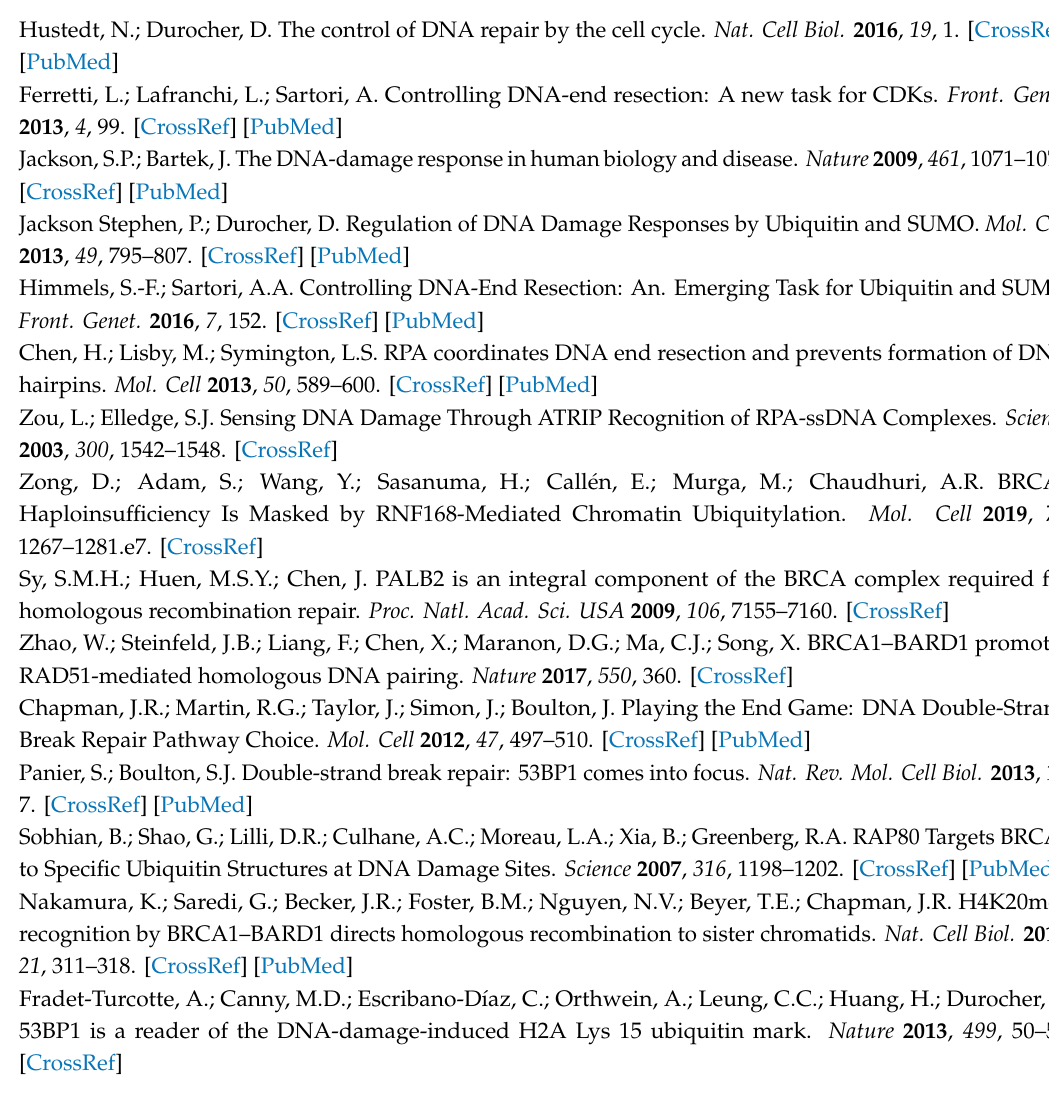
Figure S1: WIP1 inhibition impairs HR and increases sensitivity to DNA damage, Figure S2: Loss of WIP1 delays removal of 53BP1 foci in U2OS cells, Figure S3: WIP1 inhibition delays removal of 53BP1 foci in MCF7 cells, Figure S4: WIP1 dephosphorylates BRCA1 and 53BP1 in vitro and in situ, Figure S5: Loss of WIP1 increases BRCA1 phosphorylation at S1524, Figure S6: Loss of WIP1 increases IR-induced phosphorylation of 53BP1 at